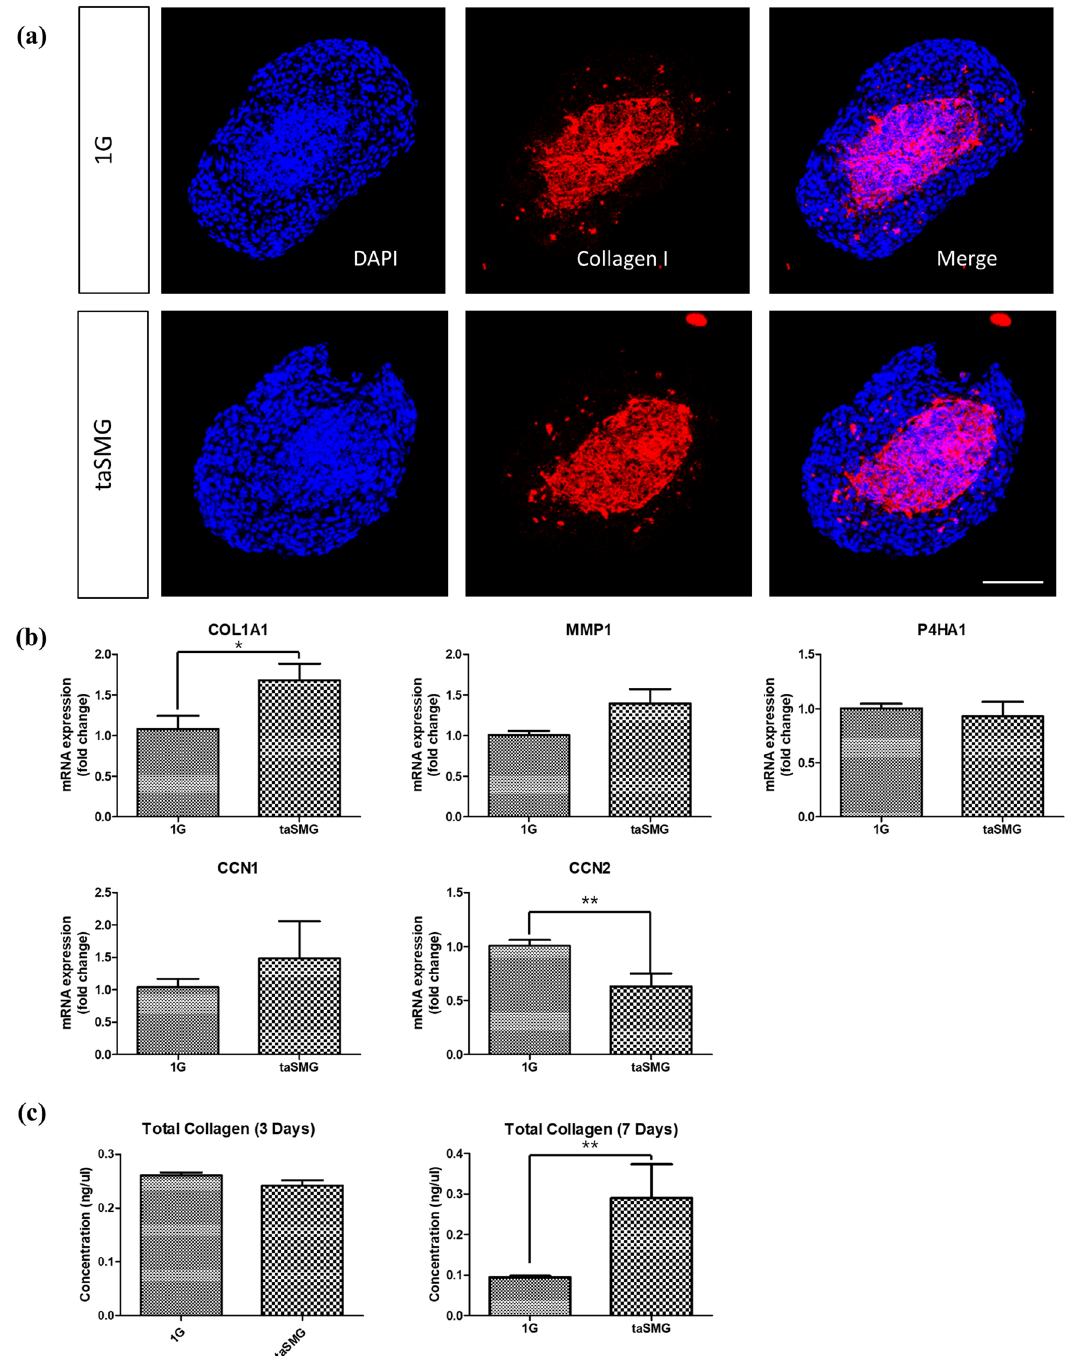
Fig. 3 Extracellular matrix homeostasis of co-cultured spheroids under 1 G and taSMG. a Collagen type I and DAPI staining showing collagen expression in the fi broblast core and both nuclei of the keratinocyte layer and fi broblast core. Scale bar: 100 μ m. b qRT-PCR analysis of COL1A1, MMP-1, P4ha1, CCN1, and CCN2. c Hydroxyproline assay result indicating collagen contents in spheroids after 3 and 7 days. Data represent the mean ± SEM ( n = 4, * p < 0.05, ** p <